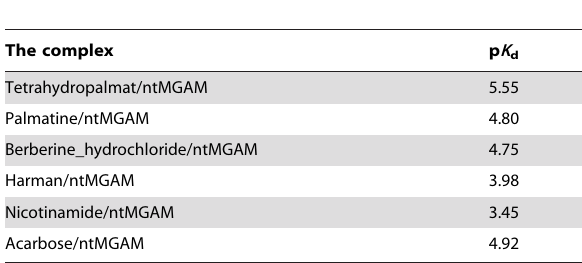
Table 1. Molecular docking study of main components from different plants and ntMGAM.